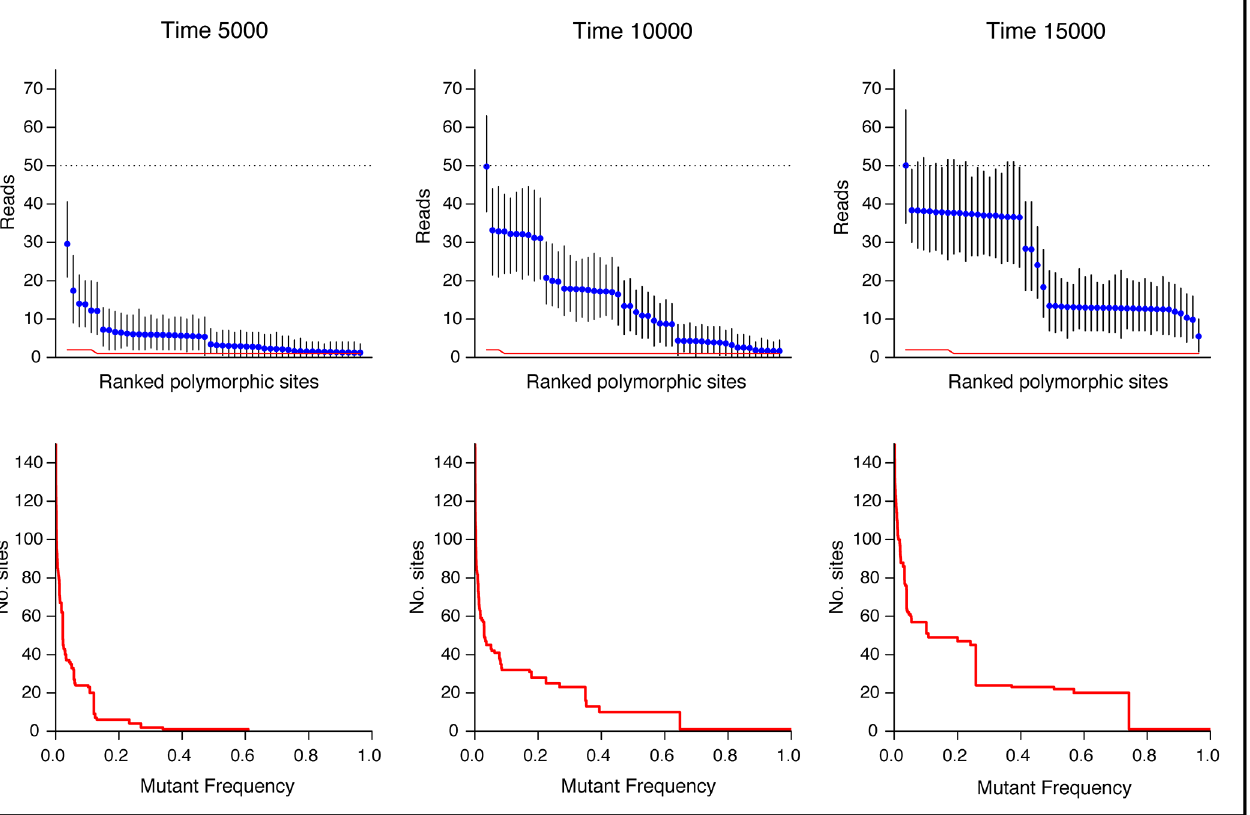
Fig 7. Frequency of polymorphic sites over time from simulated data. A population of equilibrium size 10,000 with a 100kb genome was generated over 15,000 generations using the simulatepopulation() function. The top row of plots, generated with the plotobservedsnps() function, show the expected frequency of polymorphisms under a deep sequencing project with an average 50x coverage and 0.1% per site error rate. All polymorphisms present at each time point are ordered by frequency, and plotted, together with 95% confidence intervals. The red line represents binomially-distributed polymorphisms observed via sequencing error. Polymorphisms with intermediate frequency (iSNPs) can be seen to move towards fixation of the time course, with one polymorphism reaching fixation before time 10,000. The bottom row shows the number of polymorphisms at each frequency level, generated using the plotsnpfreq()